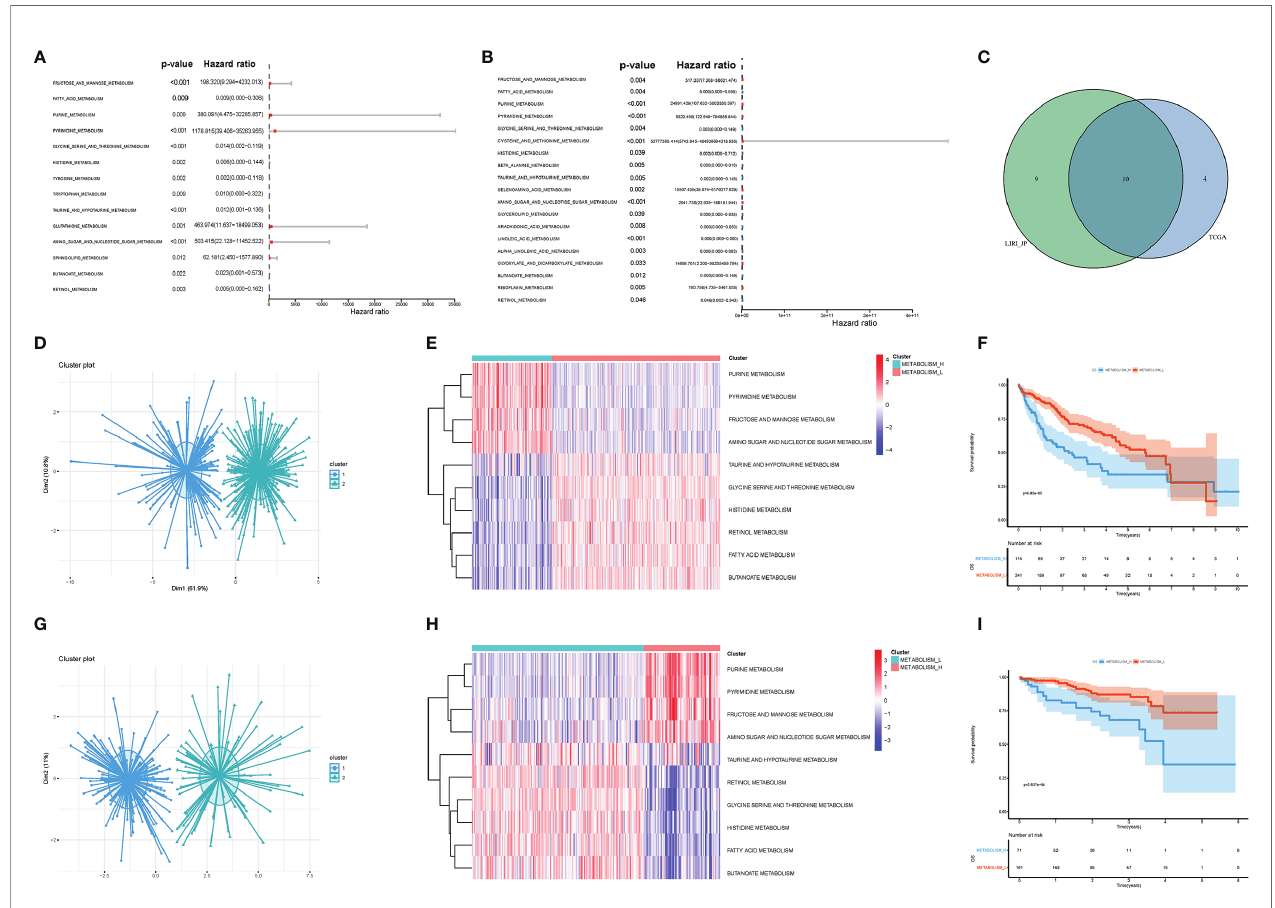
FIGURE 2 | Metabolism-related pathways pro fi ling identi fi ed two HCC clusters. (A) In TCGA, univariate Cox analyses showed that there were 14 signi fi cant metabolic pathways contributing to OS in HCC. (B) In LIRI_JP, there were 19 signi fi cant pathways. (C) A Venn diagram showed 10 metabolism-related pathways shared by TCGA and LIRI_JP. (D, E) Based on the different gene expressions of the 10 pathways, HCC was clustered: Metabolism_H and Metabolism_L in TCGA. (G, H) HCC was also clustered: Metabolism_H and Metabolism_L in LIRI_JP; Kaplan – Meier survival analysis results indicated that the two clusters had signi fi cantly different survival rates in both (F) TCGA (log-rank test p -value = 6.02e − 05) and (I) LIRI_JP (log-rank test p -value = 2.527e − 04). HCC, hepatocellular carcinoma; OS, overall